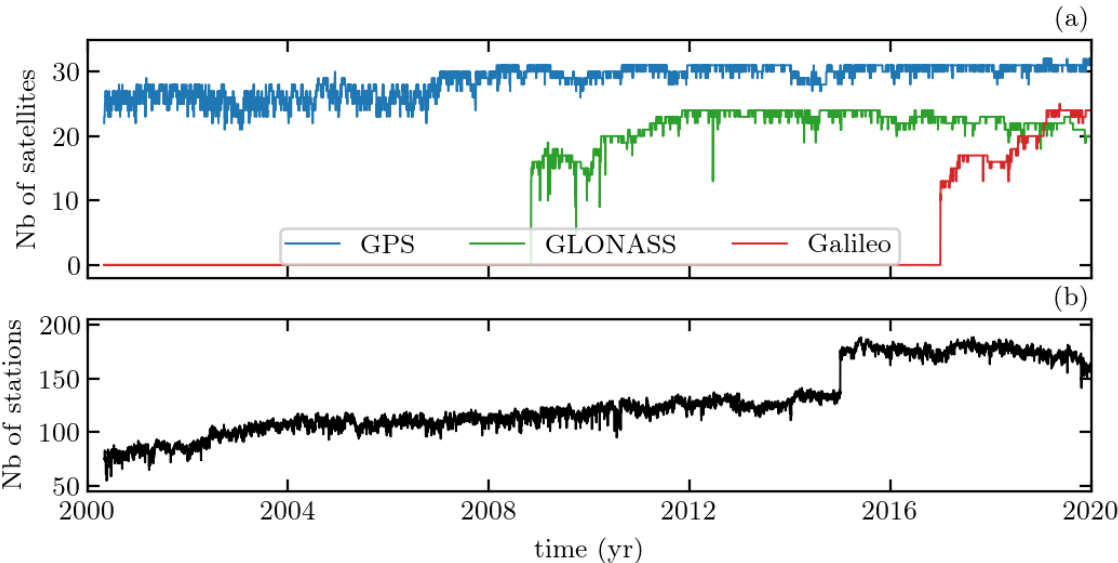
Figure 2. ( a ) Number of satellites and ( b ) number of stations used in MG3 product computation as a function of